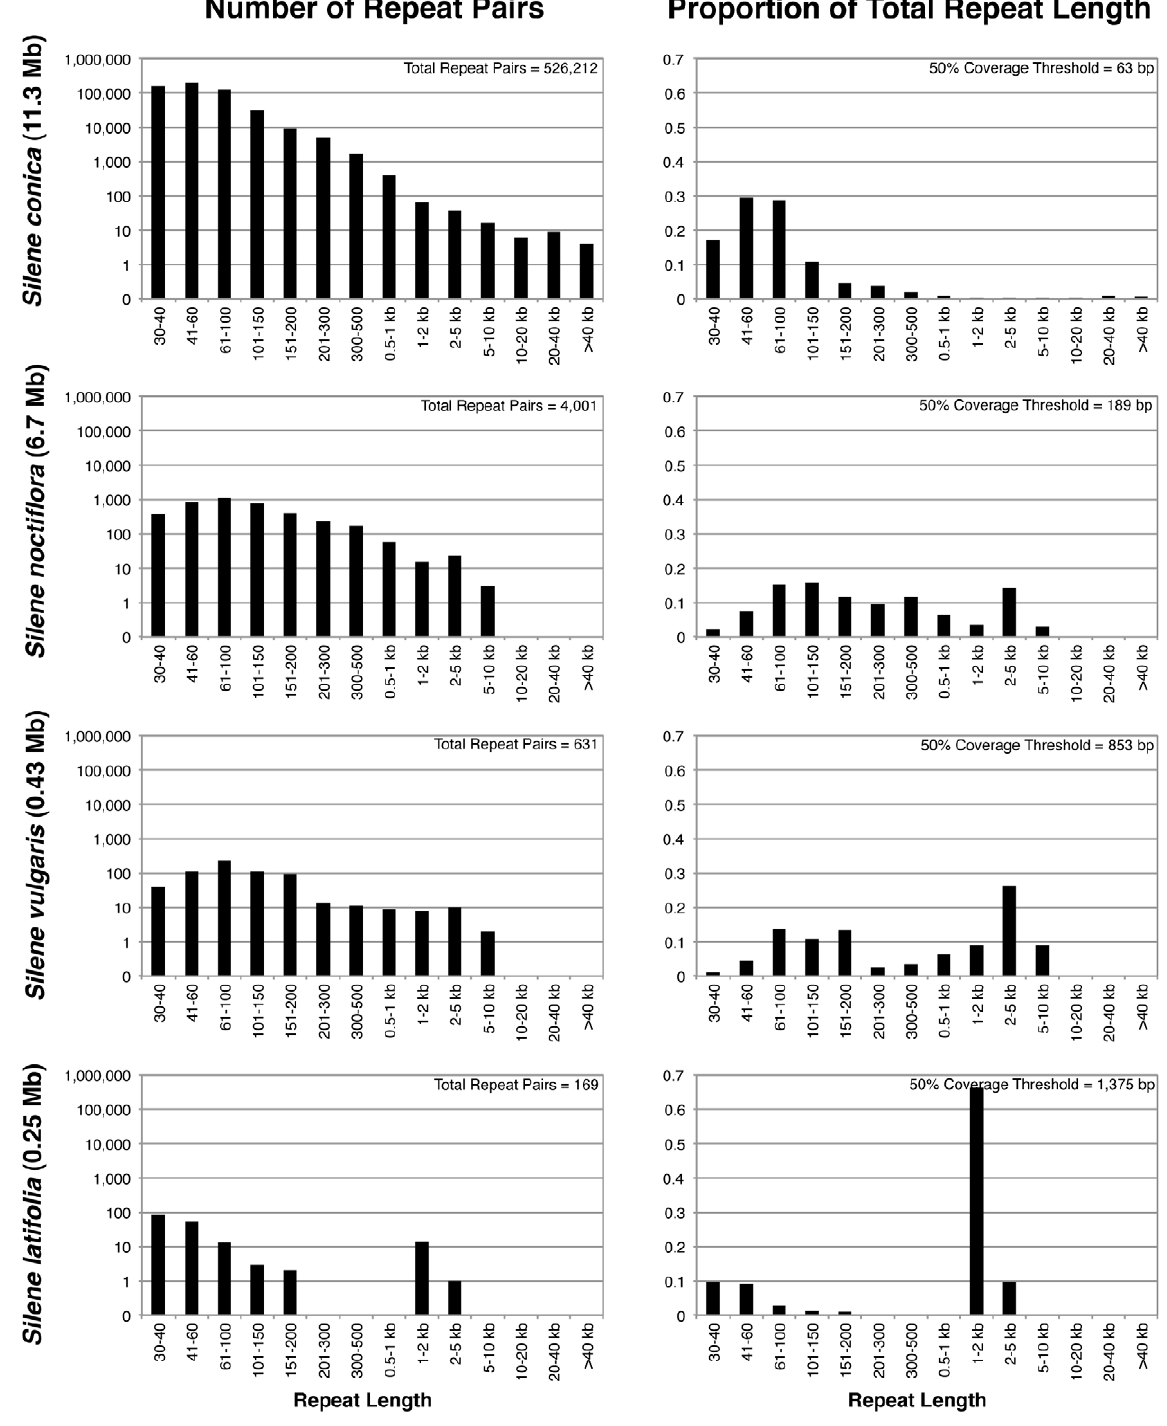
Figure 5. Size distribution of repetitive content by the number of repeat pairs (left column) and total repeat length (right column). Both datasets are based on all repeat pairs identified with BLAST by searching each genome against itself. Note that this method is different than counting individual repeat copies, which cannot be unambiguously identified when repeats exist in numerous partially overlapping copies, as they do in these genomes. For example, a repeat with four copies would be associated with six unique repeat pairs . Because of the enormous number of multicopy, overlapping repeats in S. conica , the total length of repeat pairs exceeds the size of the genome even though more than half of it is single- copy. For these same reasons, the distribution of repeat lengths in this figure differs from the repeat coverage statistics reported in Table 1, which consider what fraction of the genome is covered by repeats but not the total number of repeat pairs. The reported 50% coverage threshold represents the median of the total repeat length distribution.